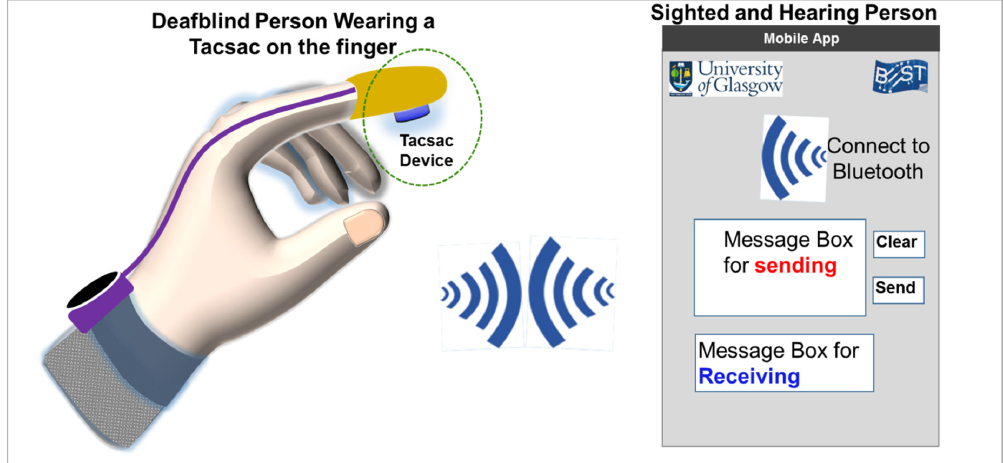
Figure 1. Application of the Tacsac device.